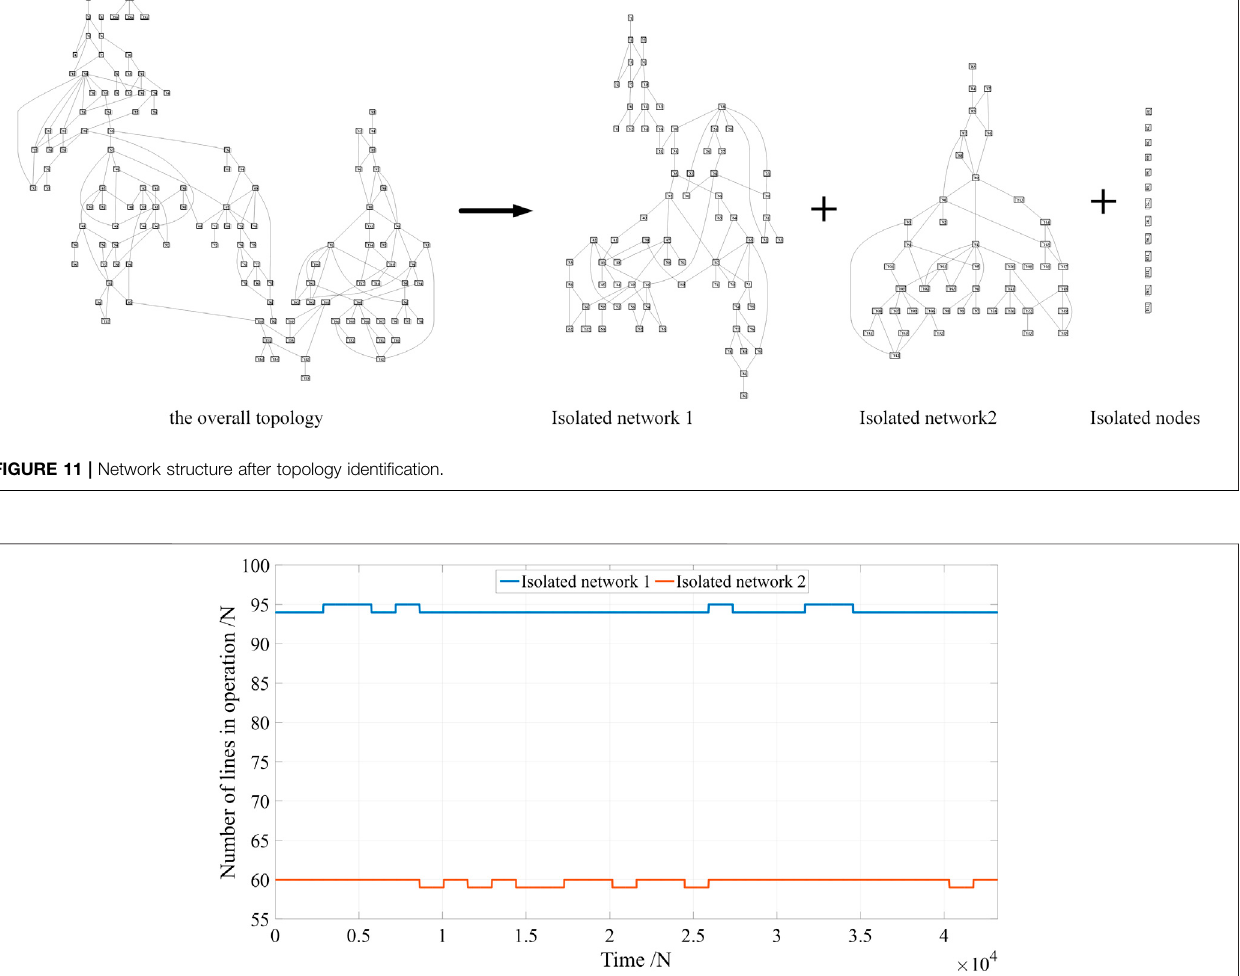
Frontiers in Energy Research |